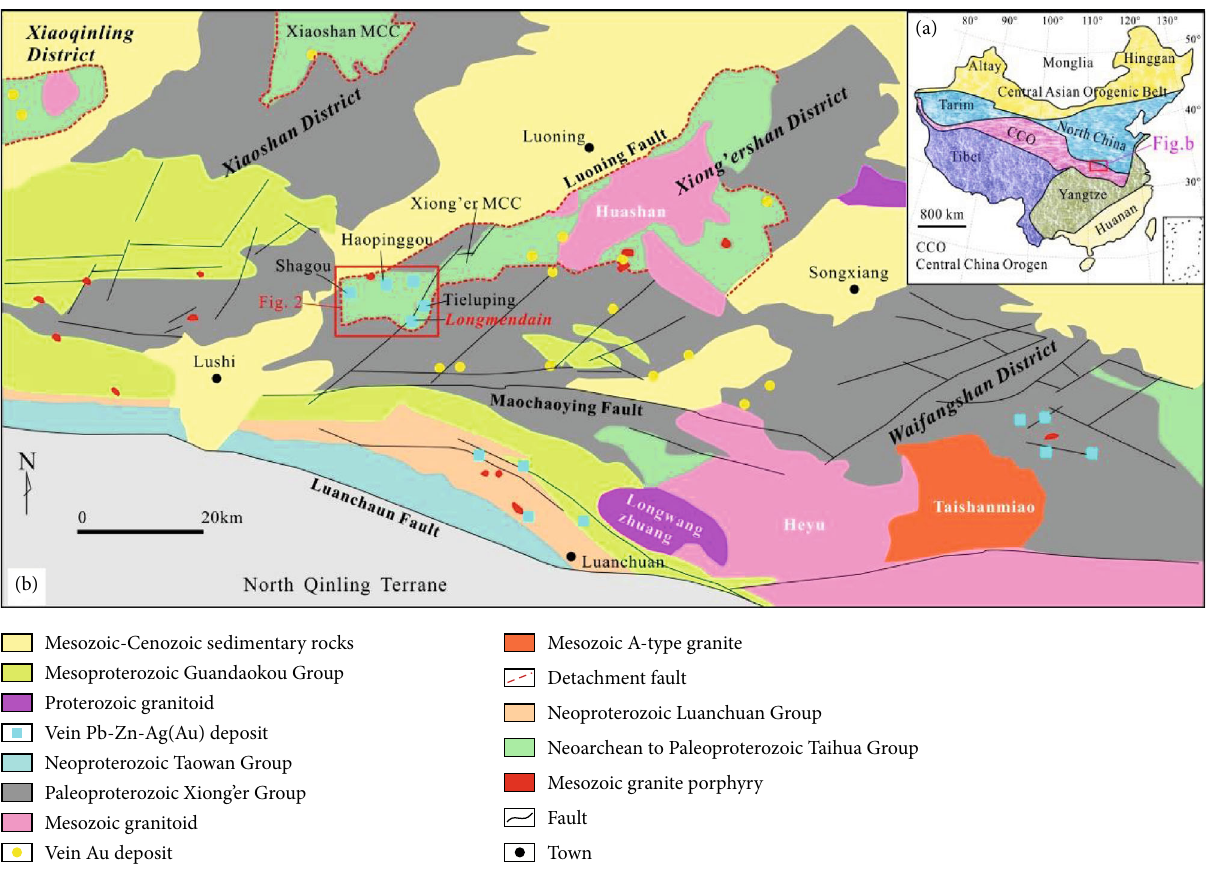
Figure 1: Location and regional geology of the East Qinling Orogen. (a) Tectonic framework of China, showing the location of Qinling Orogen. (b) Regional geologic map of the Xiong ’ er terrane, showing the location of the Shagou Ag-Pb-Zn ore fi eld. MCC: metamorphic core complex (modi fi ed from [18,